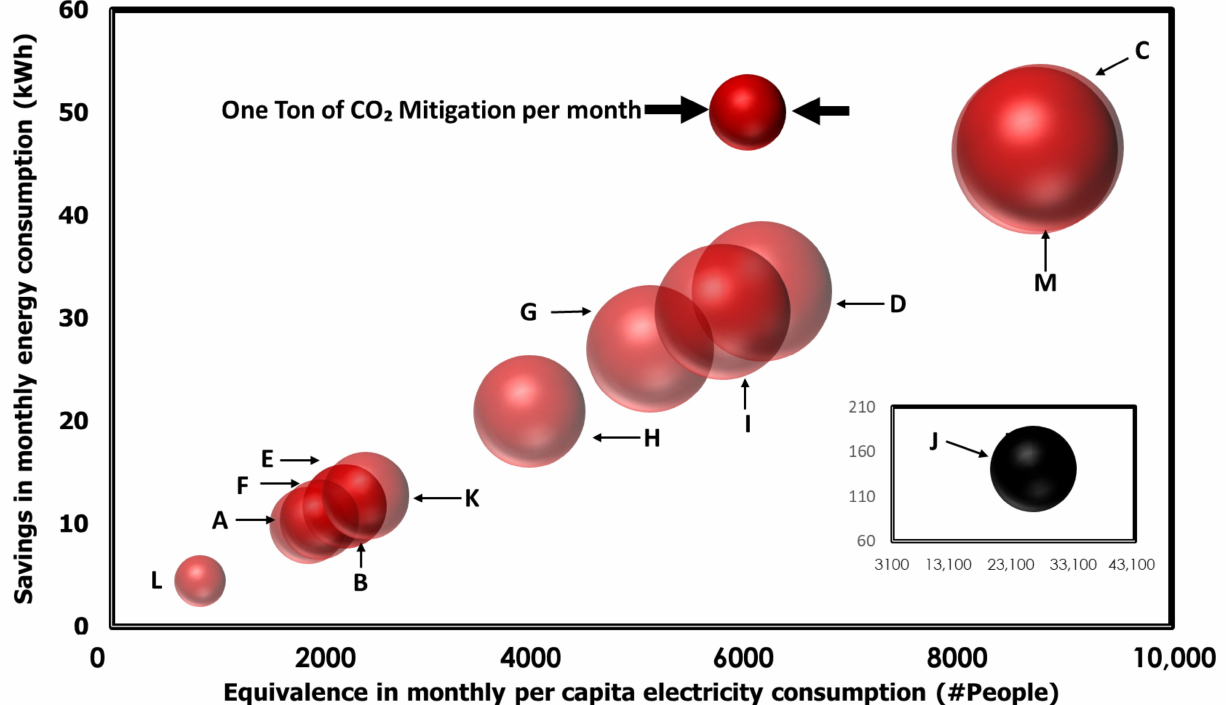
Figure 6. Multivariate analysis of energy consumption by